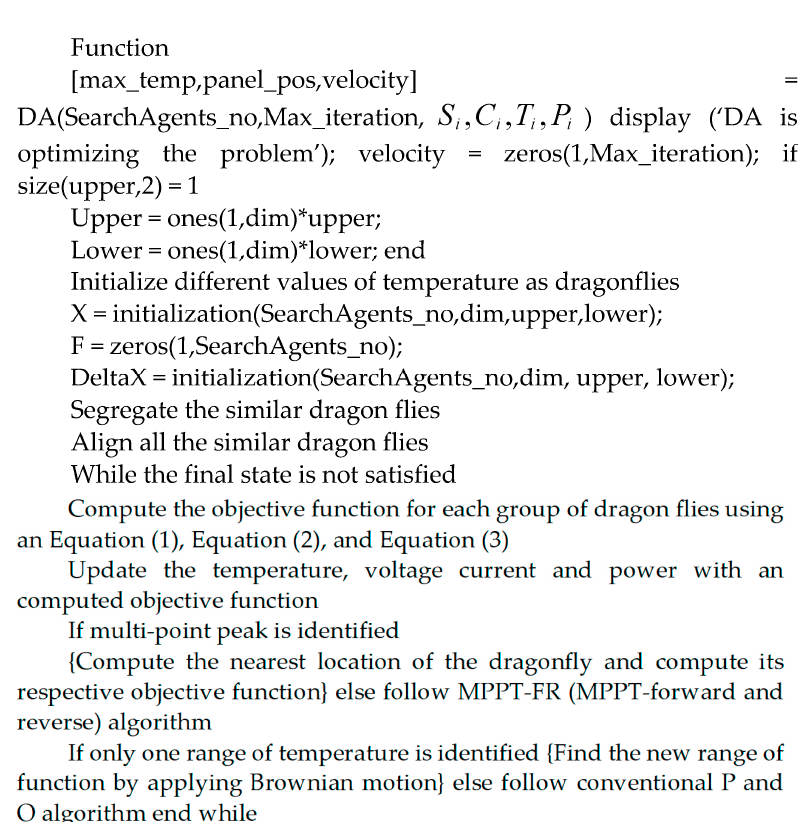
Figure 7. Dragonfly MPPT-FR